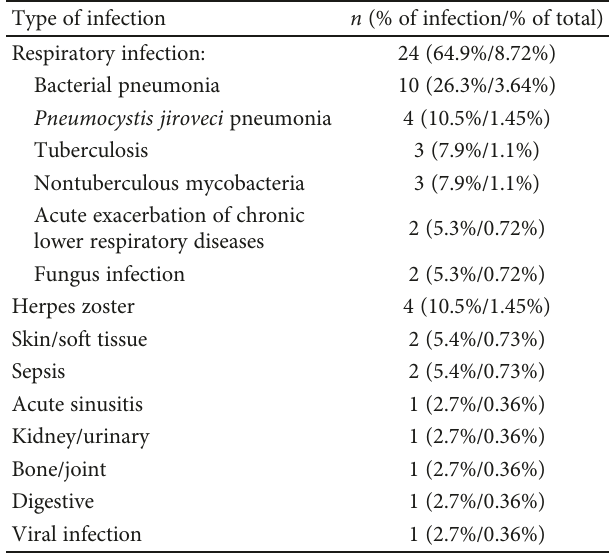
Table 2: Classi fi cation of infection and its frequency of infection and whole